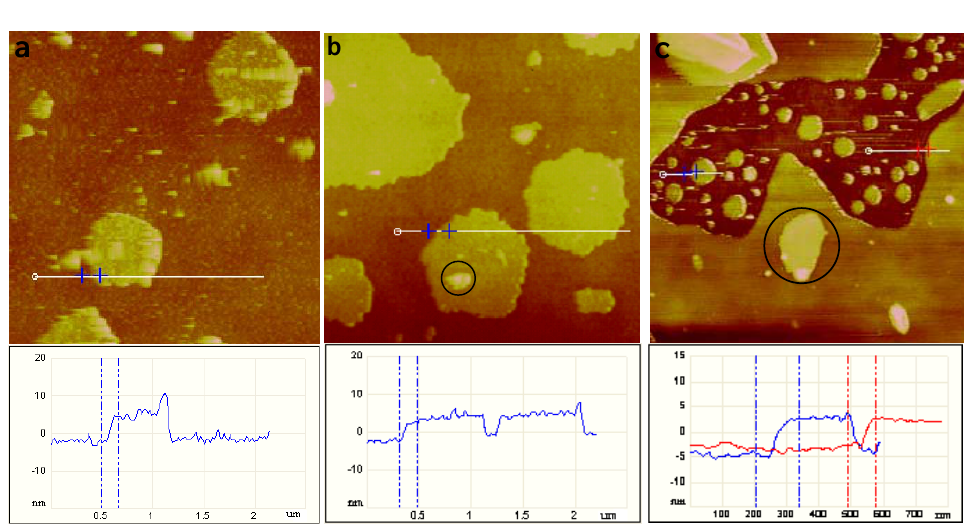
Figure 2. A series of AFM height images (image size 3 × 3 µm 2 ) of bigger unilamellar vesicles adsorbed on silicon substrate and their corresponding cross-section analyses. Images were obtained after incubation of the substrate in a vesicle solution (0.2 mg/mL) for (a) 10 min, (b) 20 min, (c) 30 min, (d) 60 min, (e) 2 h, and (f) 5 h